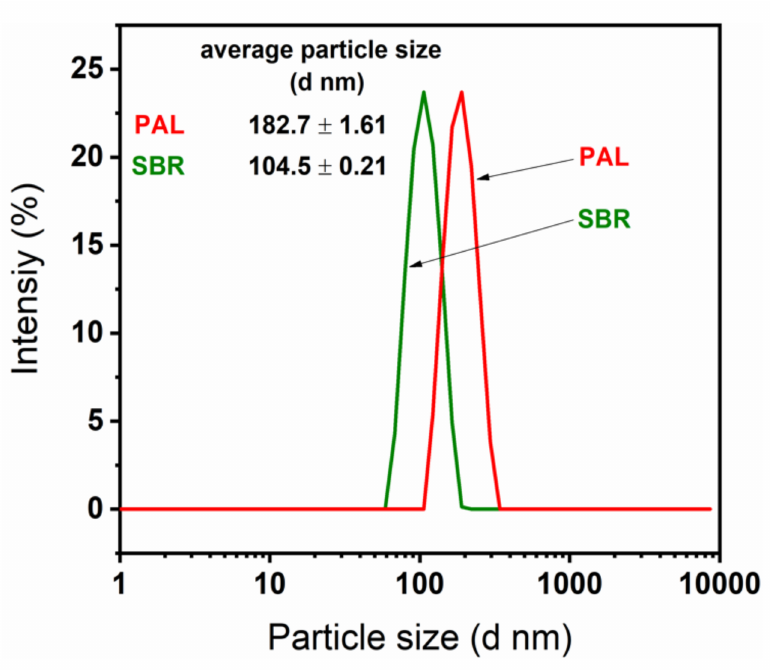
Figure 2. Particle size distribution of PAL and SBR